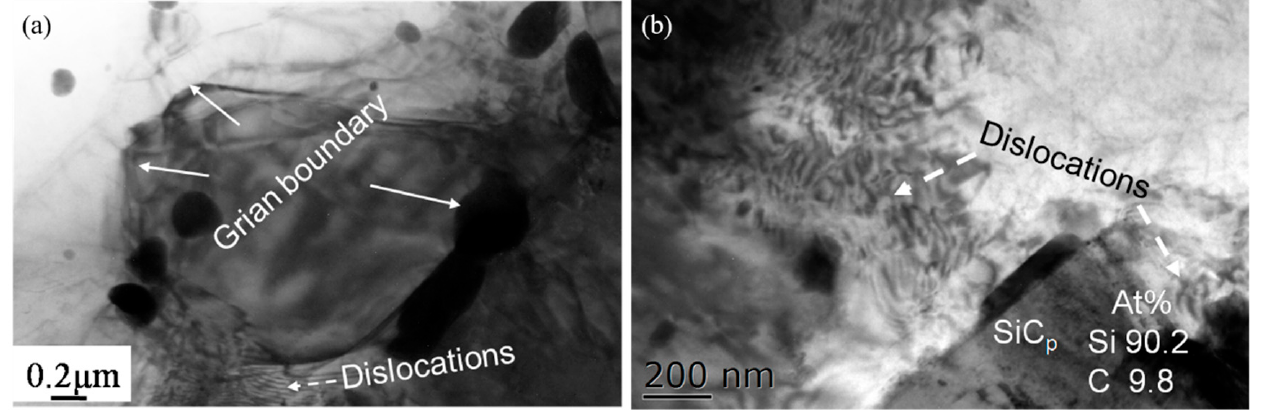
Figure 9. EBSD results of the SiC p /Mg-5Zn material with a compression strain of 0.35: ( a1 – a3 ) IPF maps, ( b1 – b3 ) grain boundary distribution maps and ( c1 – c3 ) KAM map.